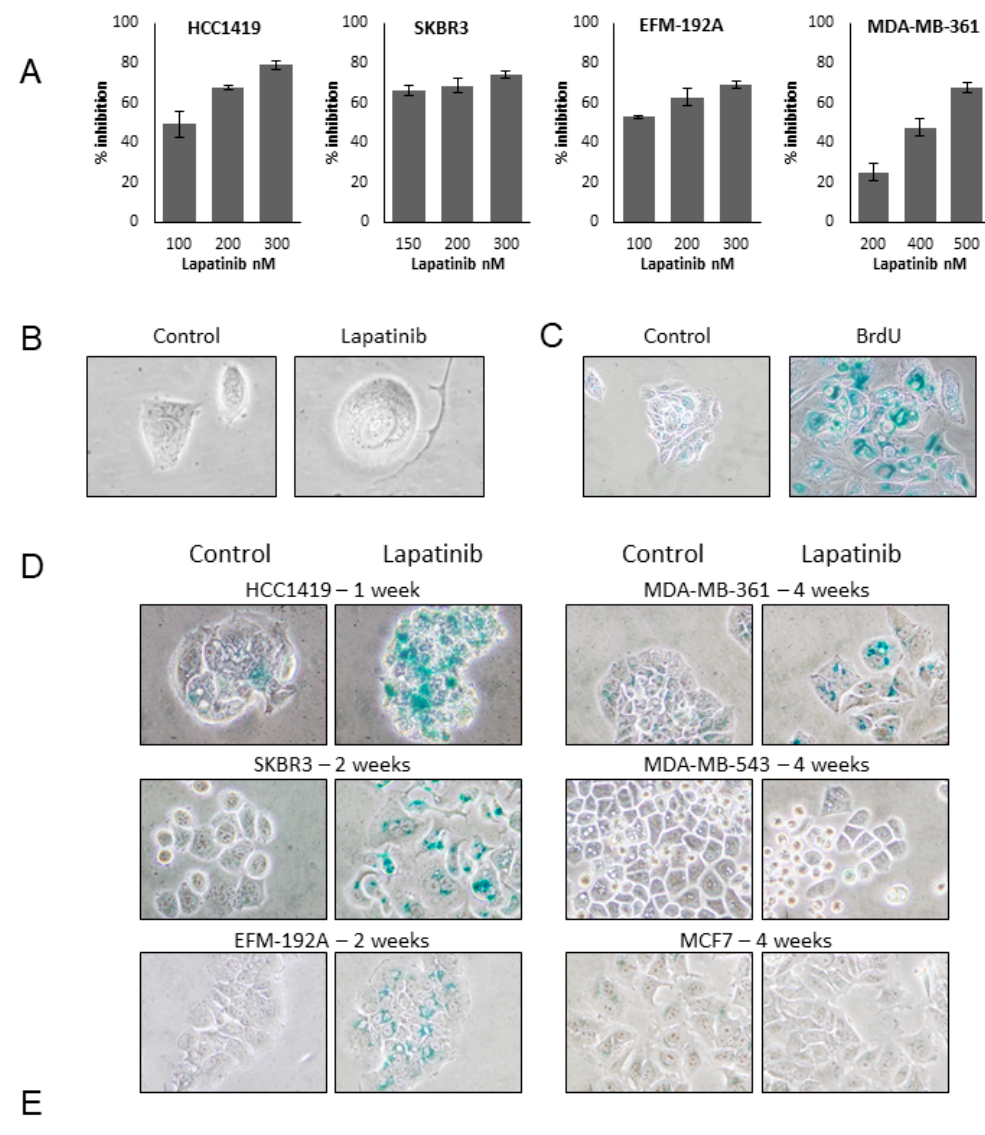
Figure 1. ( A ) Effect of varying concentrations of lapatinib on the growth of HER2 positive breast cancer cells. Cells were treated for 4 days and then counted using Viacount on the Guava system. The effect of lapatinib on the growth of cells was determined relative to untreated control cells (error bars reflect n = 3). ( B ) HCC1419 cells were treated twice weekly with 250 nM lapatinib for approx. 3 months. Images taken at 400× magnification. ( C ) HCC1419 cells were treated twice weekly with 50